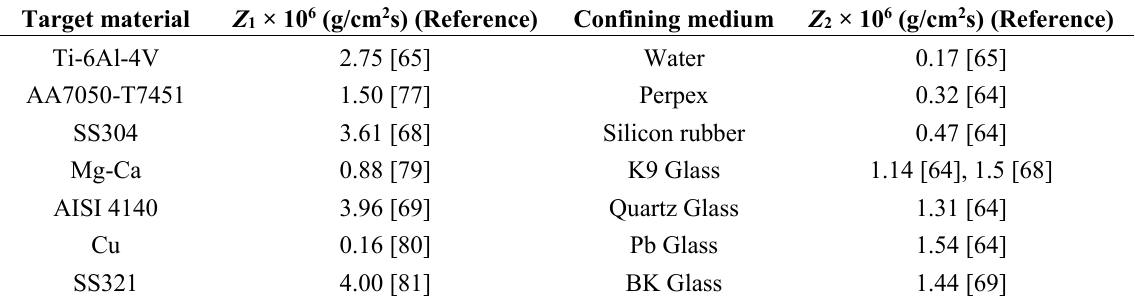
Table 1. Typical values of Z 1 and Z 2 as reported by different